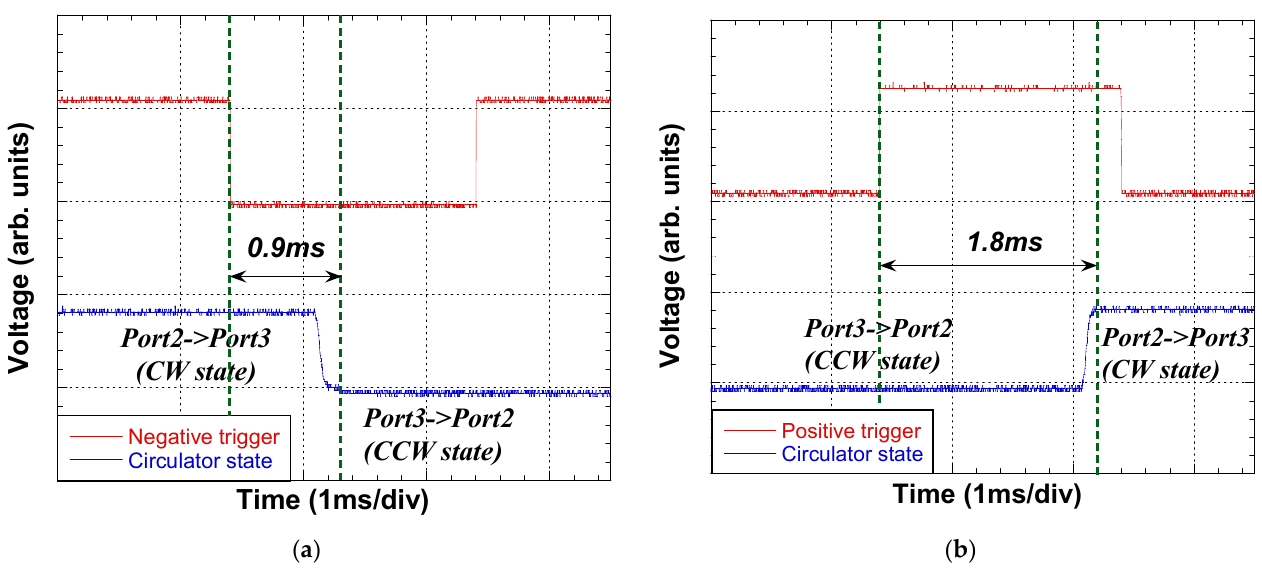
Figure 6. Measured response time of the four-port reversible optical circulator: ( a ) clockwise to counterclockwise and ( b ) counterclockwise to clockwise.